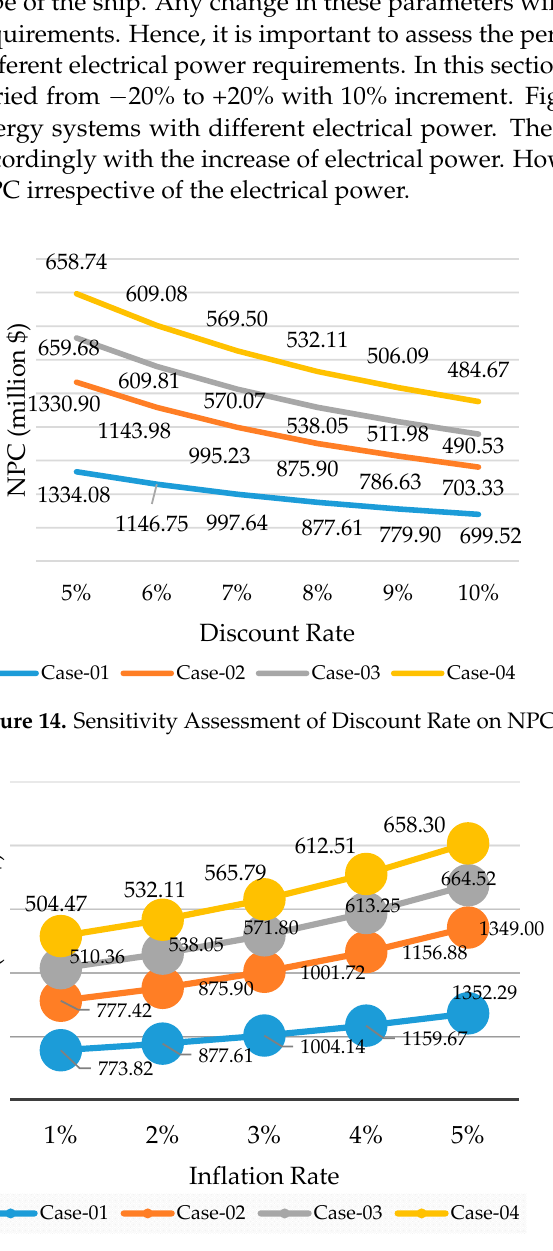
Figure 15. Sensitivity Assessment of Inflation Rate on NPC.